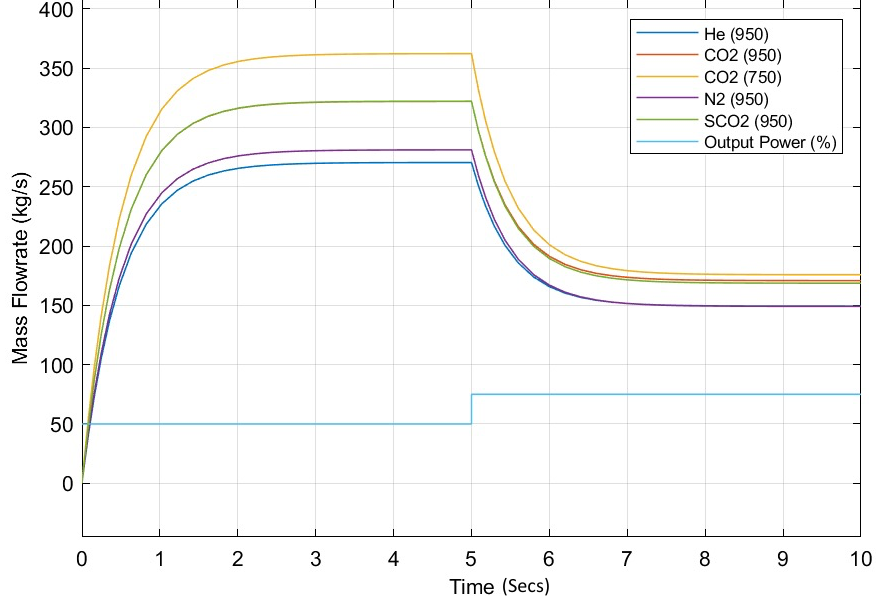
Figure 5. Control-valve response times (secs), with dynamic response and stability of mass-flow rates (kg/s) for the various working fluids. Note: SCO 2 mass-flow rate for 950 °C is comparable to 750 °C flow-rate conditions.